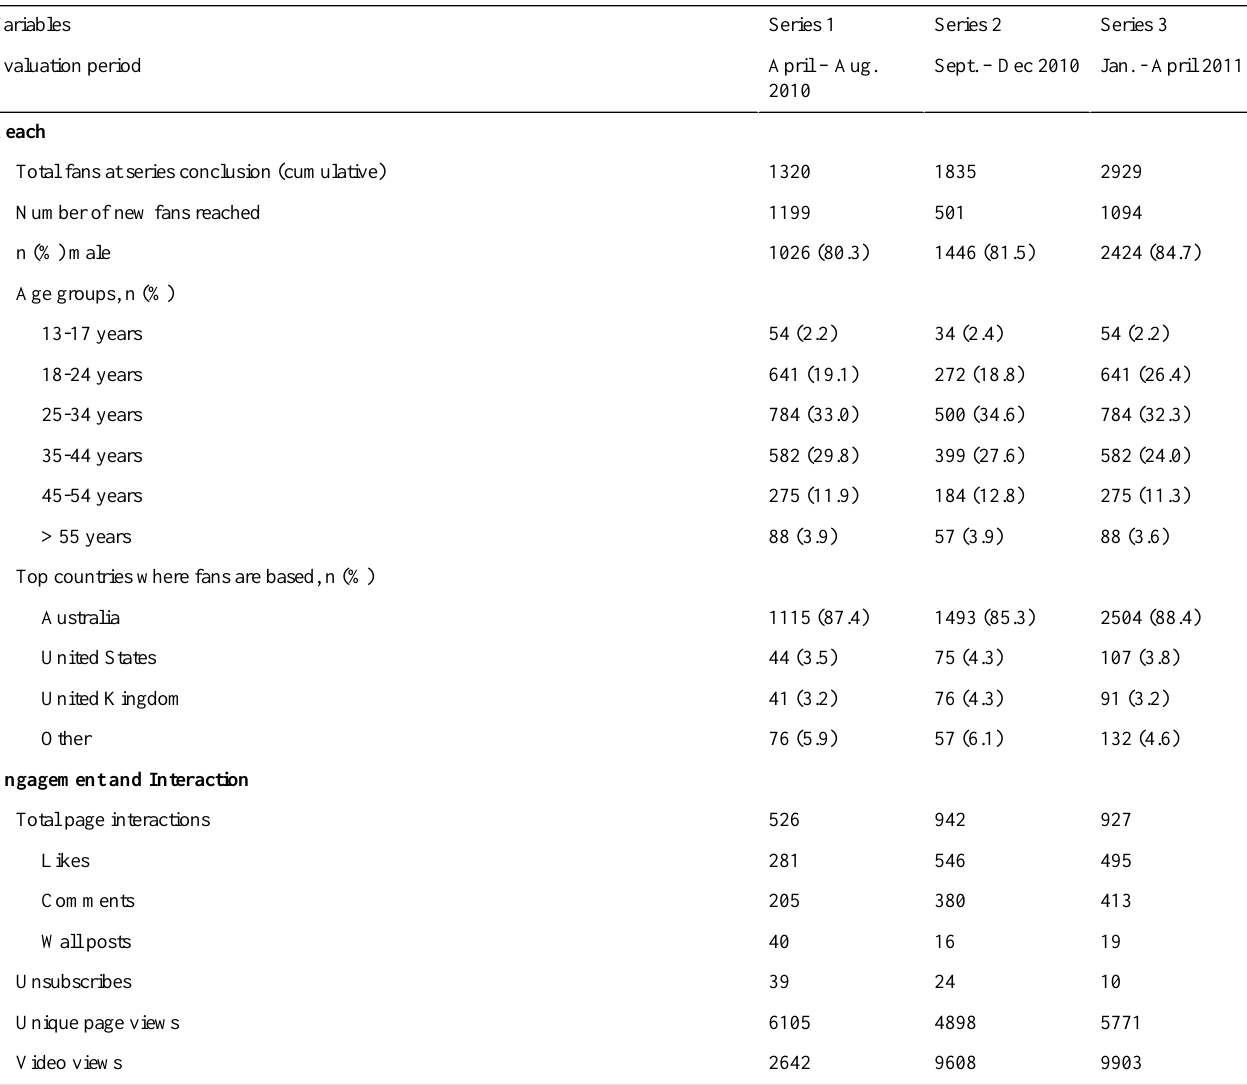
Table 1. Key metrics from the QAF Facebook page usage statistics per series (source: Facebook insights